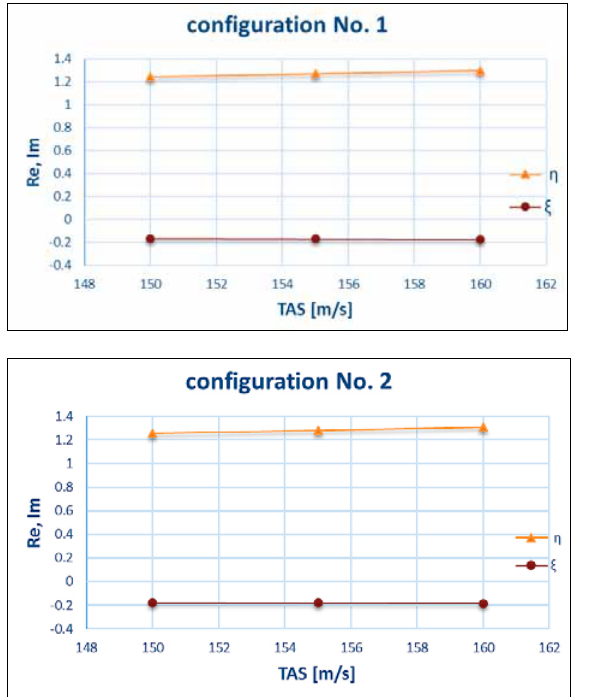
Fig. 14. Eigenvalues for the real and imaginary part for the dutch roll